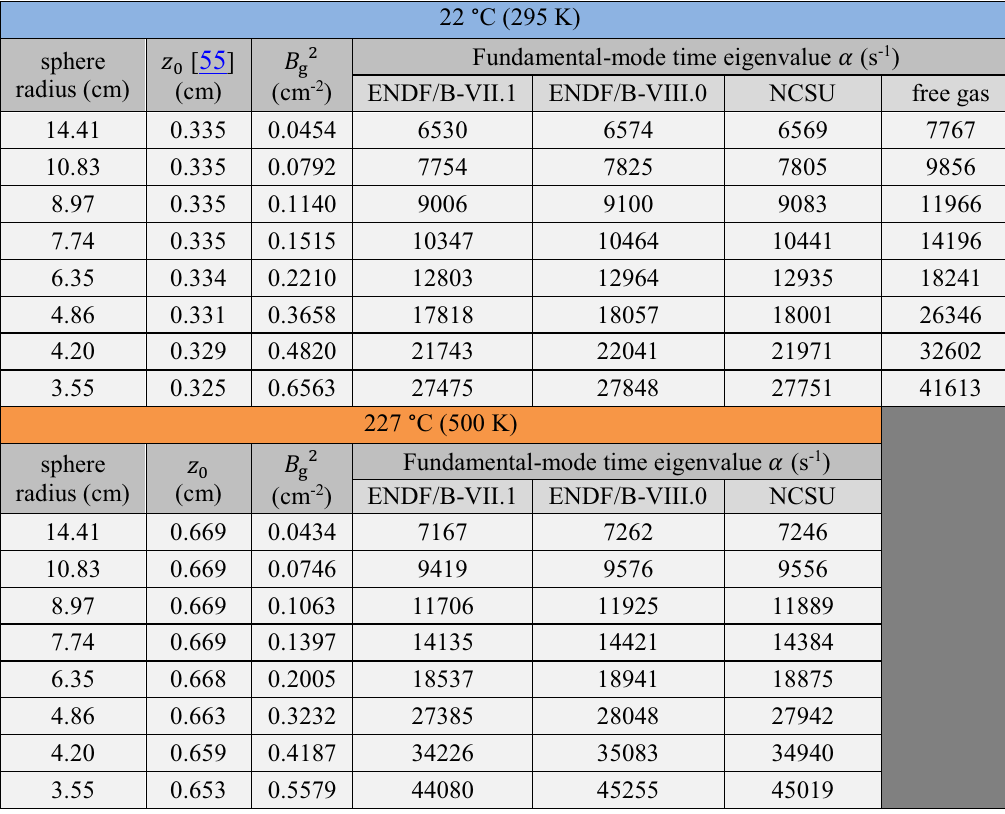
Table I. PNDA Model Data and Time Eigenvalue Results.